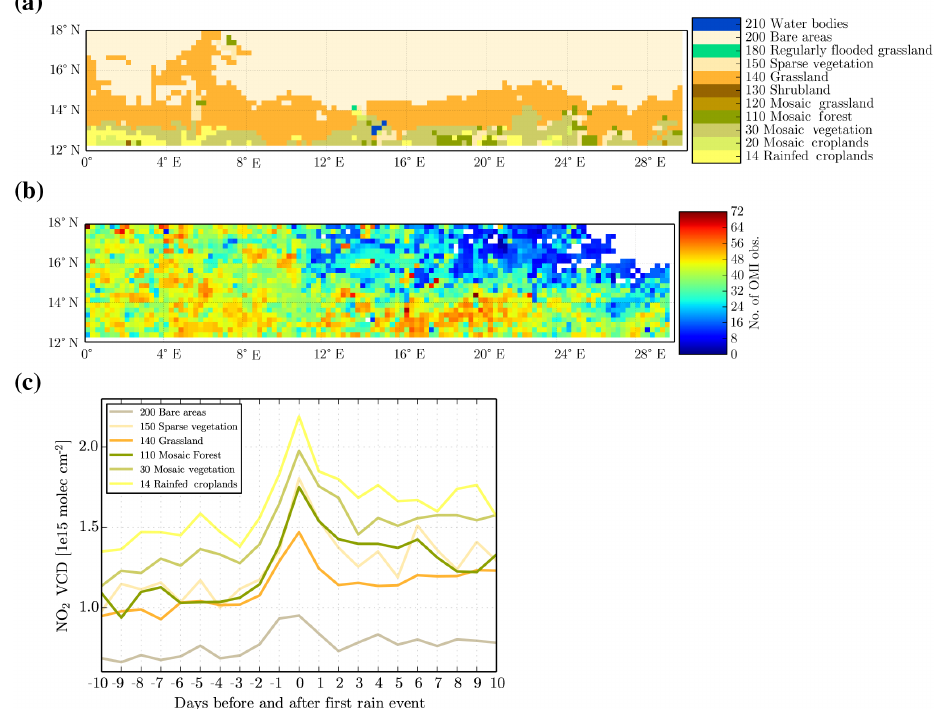
◦ × 0.25 ◦ resolution with the corresponding